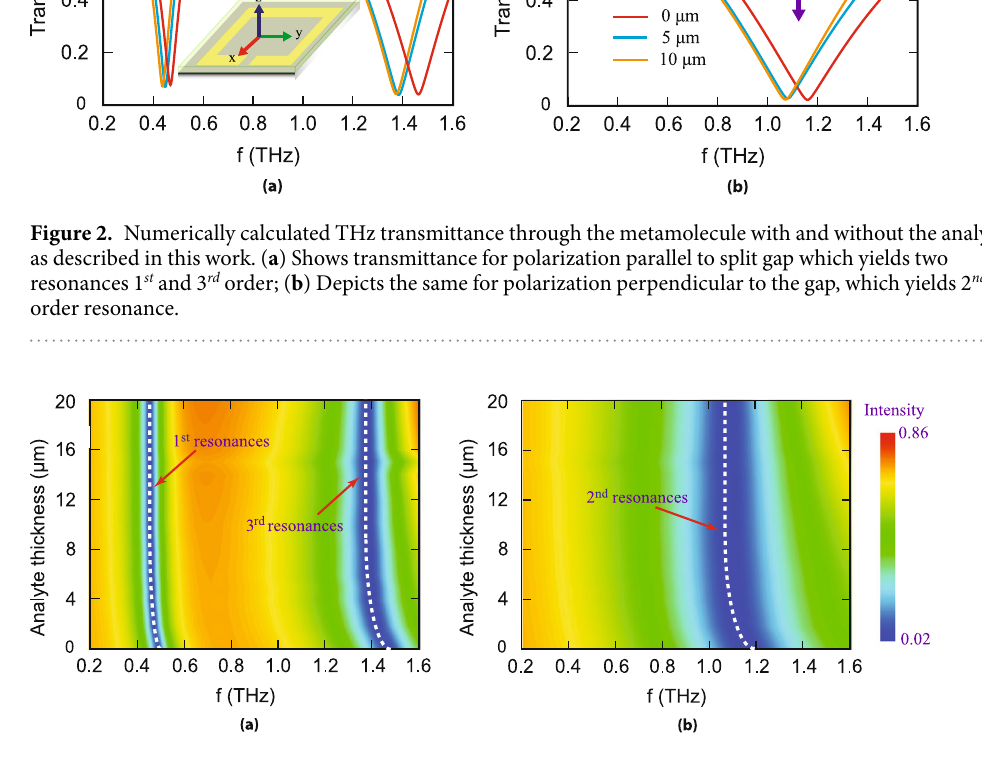
In order to comprehensively understand the reason(s) behind shift in characteristic resonance dips with var- iation in thickness of the analytes, we numerically analyze THz transmission properties of the metamaterials with varying thickness of the analyte layer. The results are depicted in the form of the contour plots shown in Fig. 3. Figure 3(a) shows the transmittance when the polarization is parallel to the split gap for different analyte thicknesses whereas, Fig. 3(b) shows the transmittance results when the polarization is perpendicular to the gap. In these plots, we have considered the frequencies ranging from 0.2 THz to 1.6 THz to accommodate the odd and even resonance modes of the designed metamaterials covered with analyte of variable thickness from d = 0 μ m to d = 20 μ m . The intensity of the terahertz transmission is represented by the different colors of the contour plots. The positions of the resonance dips are indicated with the dotted white color trace inside the contour plots. It is apparent from the plots that frequency shift in the resonance dip is prominent only up to about 14 μ m thickness of the analyte layer. It may be noted that the shift of resonance frequency is predominantly caused by the change in the capacitance of different resonance modes. We have intentionally kept the size of the resonators fixed there- fore the parameter affecting resonance shift is due to capacitance alone. Capacitance of the resonance depends on the near field distribution of the electric field lines. These field lines are highly concentrated close to the resonator and recedes away from the resonator. Beyond a certain distance (14 μ m in case of our resonator) from the resona- tor the electric field lines almost vanish and insignificant. Therefore presence of any analyte beyond 14 micron (in our case) from the resonator has virtually no influence/impact on the capacitance. Hence frequency shifts saturate around 14 μ m in our study here. This is because of the limited spread of the electric field lines surrounding the resonator. Further, we examine more specifically, the shift in the resonance frequency of the odd and even order modes with respect to the intrinsic resonances (i.e. without any coated layer) for different thicknesses of the coated ana- lyte layer. The results are shown in Fig. 4(a). As the analyte thickness is varied, we observe a corresponding shift in the resonance frequencies for each mode. Initially, the resonance frequency shift increases monotonically with the analyte thickness, however around d = 12 μ m , it attains almost a constant value. In this figure, three different coloured traces i.e. red, green and blue colour represent frequency shift plots for 1 st , 2 nd and 3 rd order resonances,